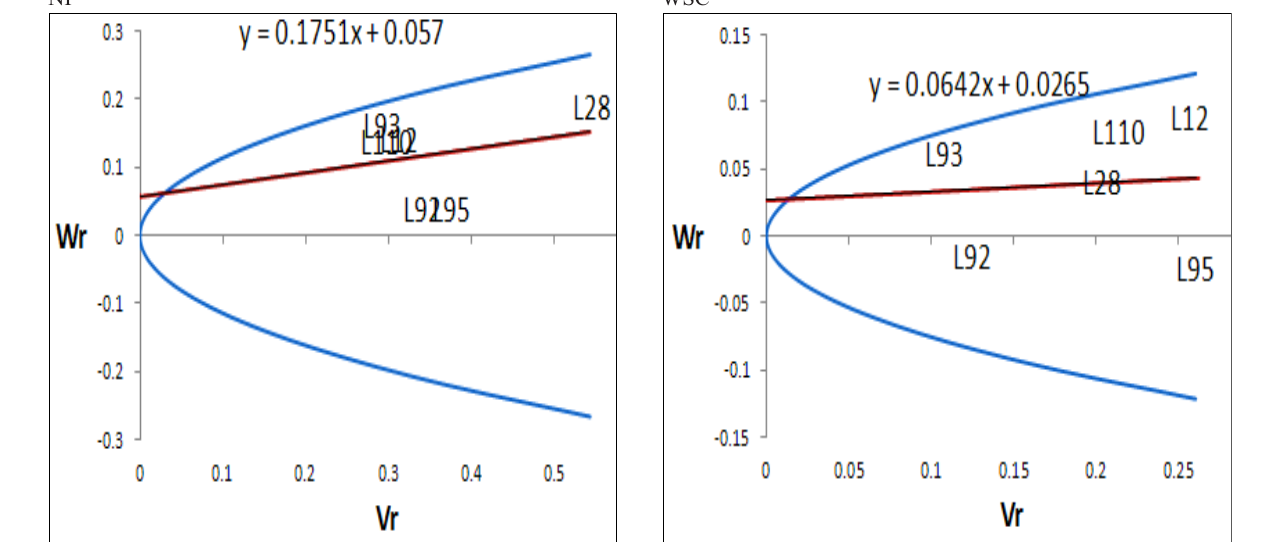
Fig. 6a: Wr/Vr graphs for 1000-seed weight under NI Fig. 6b: Wr/Vr graphs for 1000-seed weight under WSC